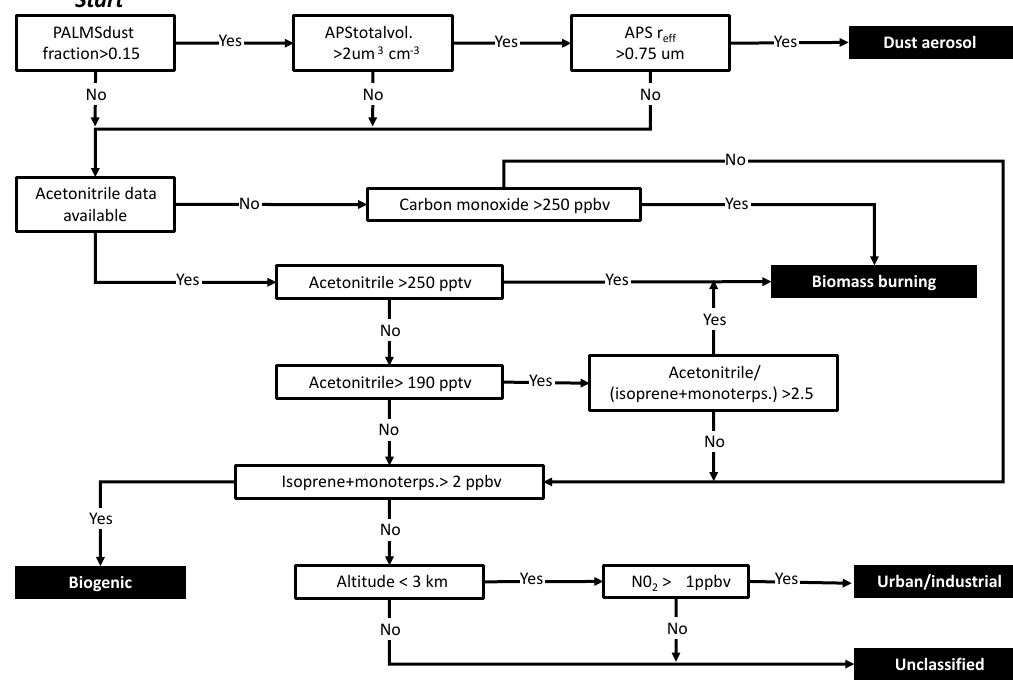
Figure 1. The decision tree used to classify aerosol types in SEAC 4 RS.